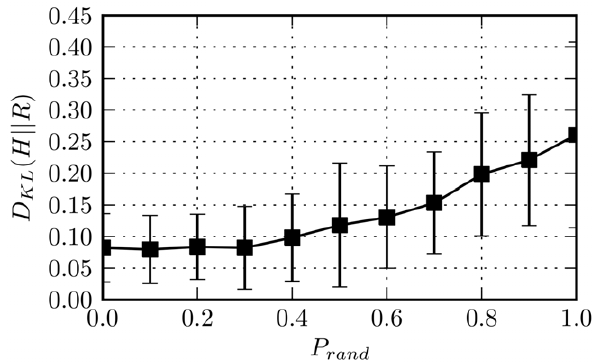
Figure 10. Geographic distribution of places in cities. Gaussian kernel density estimation (KDE) applied on the spatial distribution of places in three cities (Houston, San Francisco and Singapore). Each dark point corresponds to a venue observed in the Foursquare dataset encoded in terms of longitude and latitude values. The output of the KDE is visualised with a thermal map. A principal core of high density is observed in the three cities, but point-wise density and spatial distribution patterns may differ. The rank-based model can cope with those heterogeneities as it accounts for the relative density for a given pair of places u and v